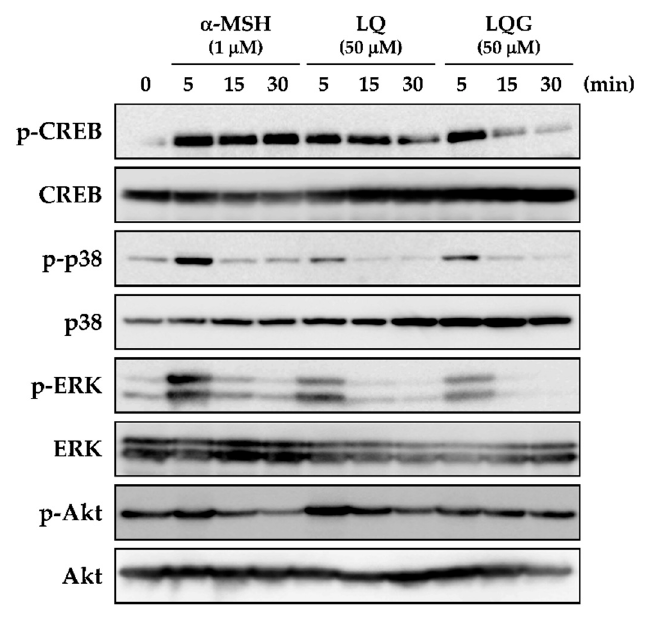
Figure 5. Effects of LQ and LQG on the phosphorylation of CREB, p38, ERK, and Akt. B16-F1 cells were treated with LQ, LQG, or α -MSH at the indicated concentrations for 5, 15, or 30 min, and then the protein expression levels were determined by Western blotting as described in Materials and Methods. The data shown are representative of 4–6 independent experiments.